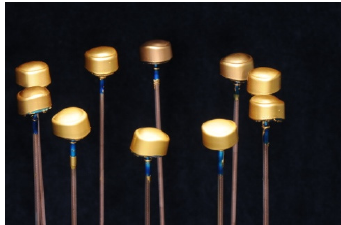
Figure 5. Primary crowns with gold copings on rods after the electroforming process.